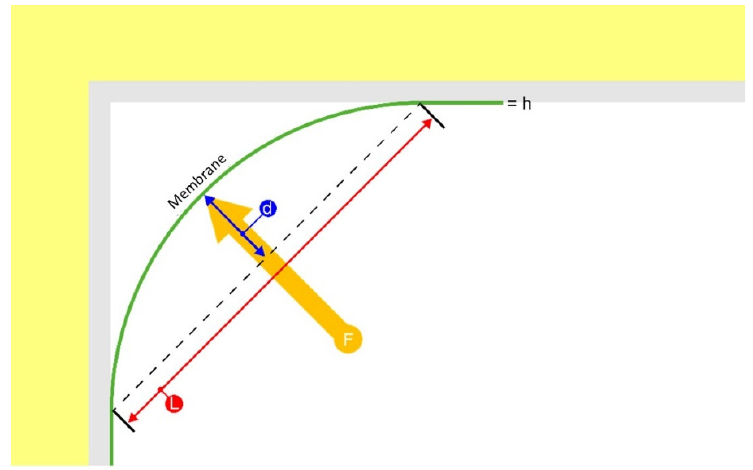
Figure 10. Bending force for a